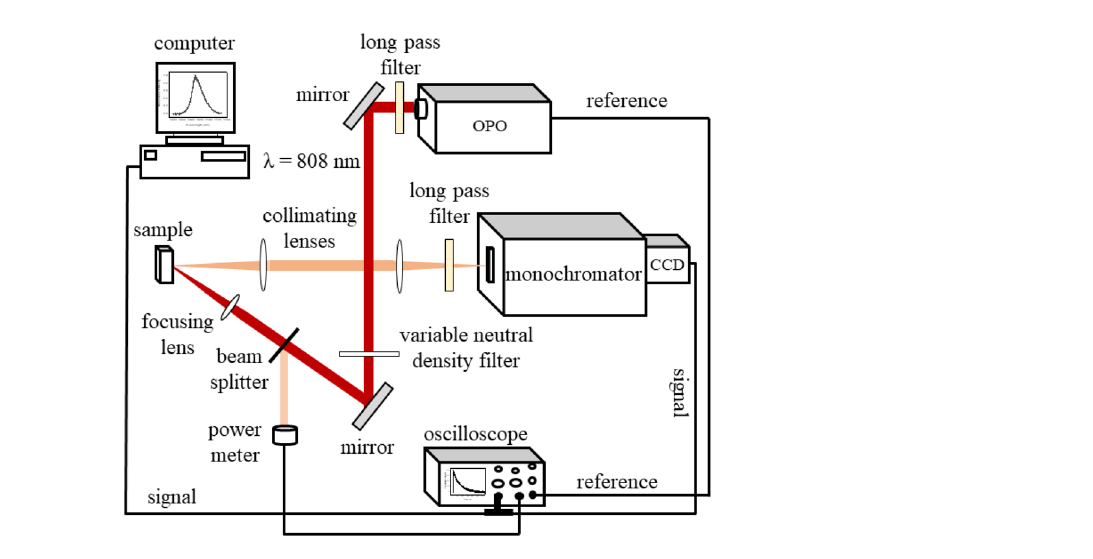
Figure 11. Setup for random laser